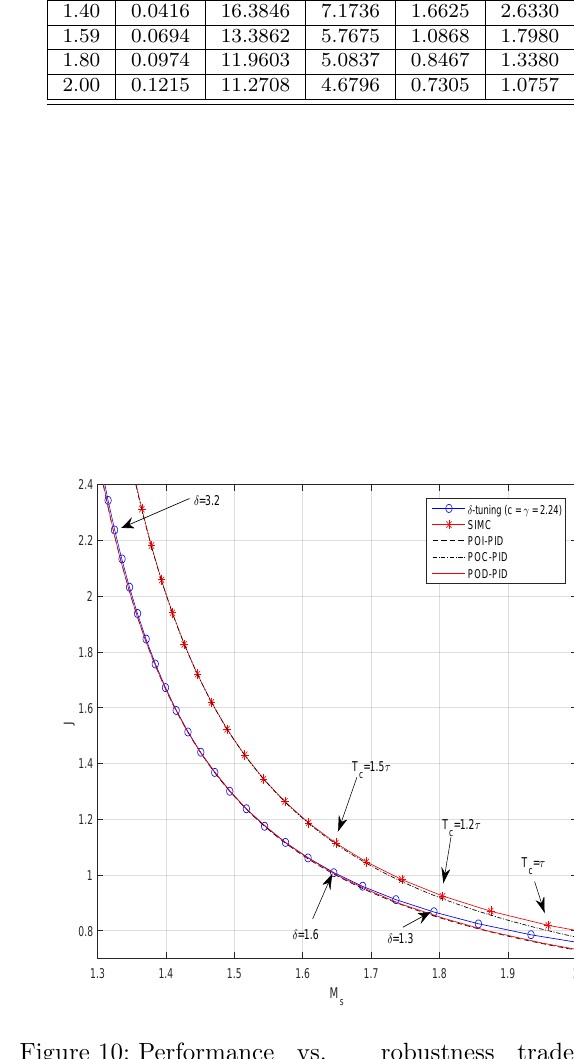
Figure 10: Performance vs. robustness trade-off = 4 . 15 IAE o = 288 . 56 curves. IAE o vy vu s r = 0 . 5. Comparing the proposed δ -tuning and SIMC vs. the POI-PID controller on the process model, h p ( s ) = e − s s 2